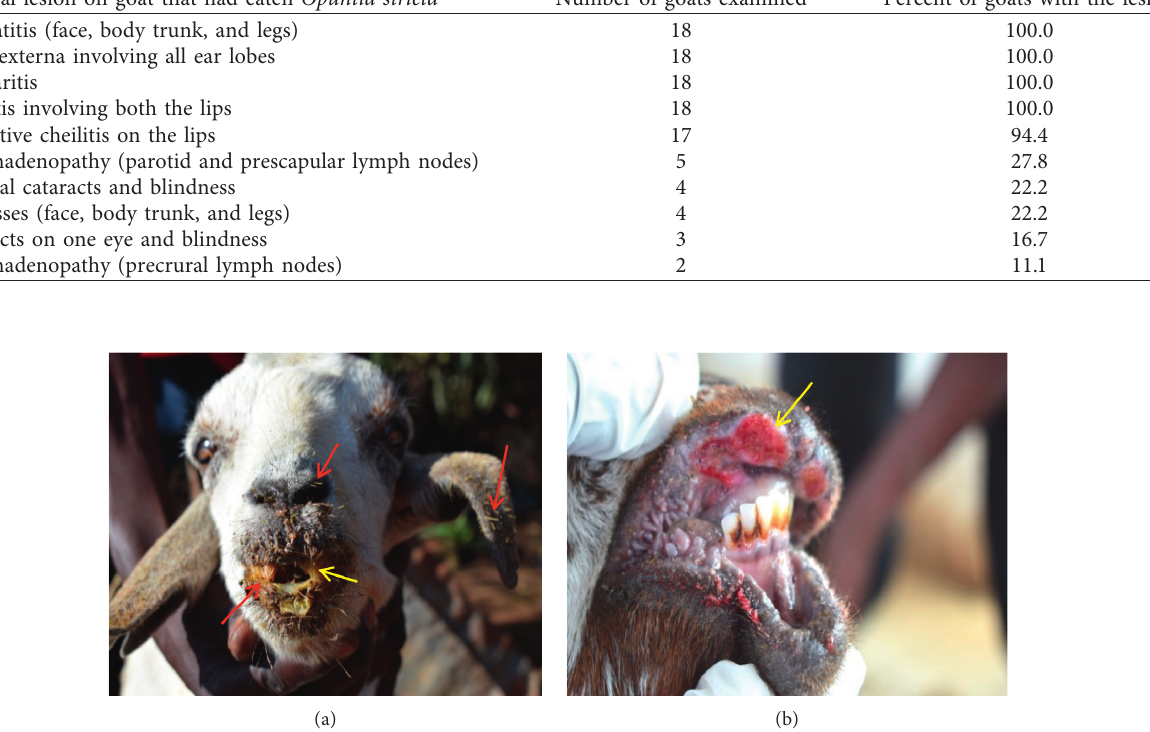
Table 2: External lesions observed on goats that had eaten Opuntia stricta in Laikipia North sub-County. External lesion on goat that had eaten Opuntia stricta